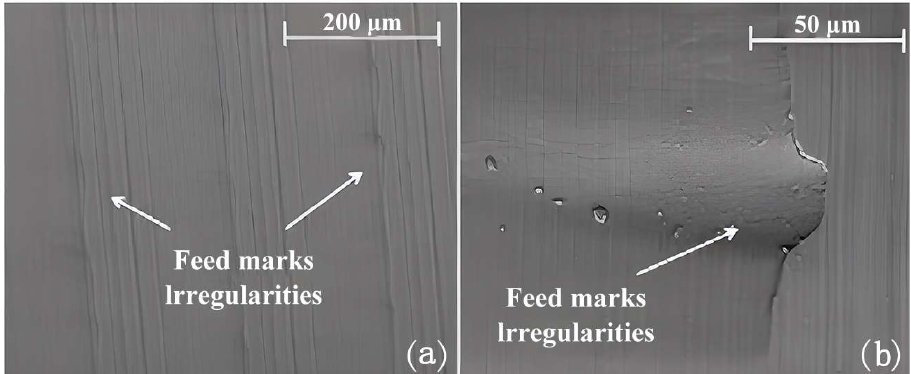
Figure 7. The feed marks and irregularities formed during turning when adopting different cryogenic cooling strategies: ( a ) 500× and ( b ) 2000× [109] (Reprinted with permission from [109]. Copyright 2016, Elsevier).